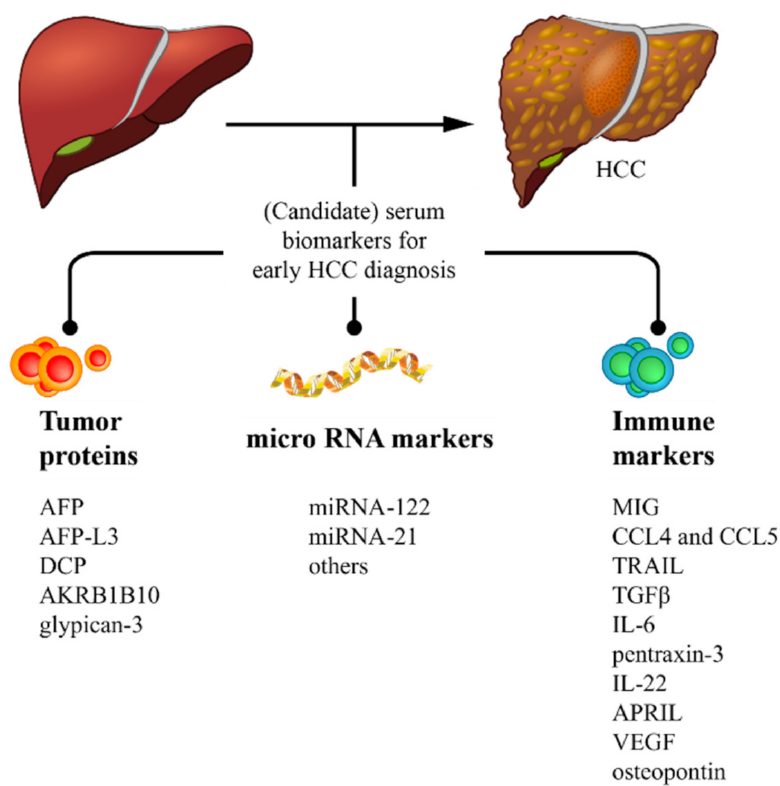
Figure 1. Graph summarizing different classifications of biomarkers discussed in the review. For abbreviations, please see the main